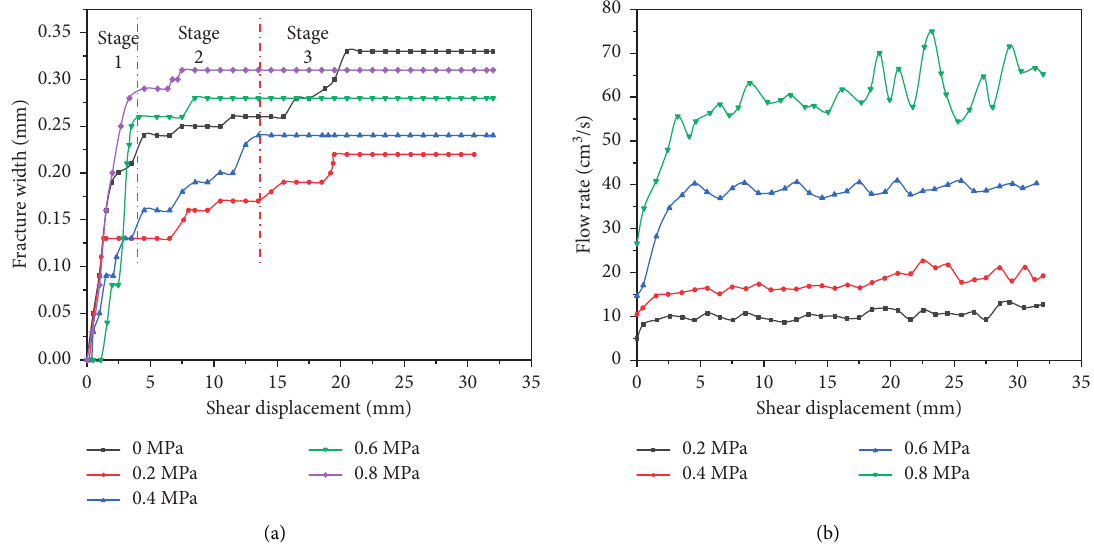
Figure 6: Flow rate and fracture aperture curve under different hydraulic pressure rates.